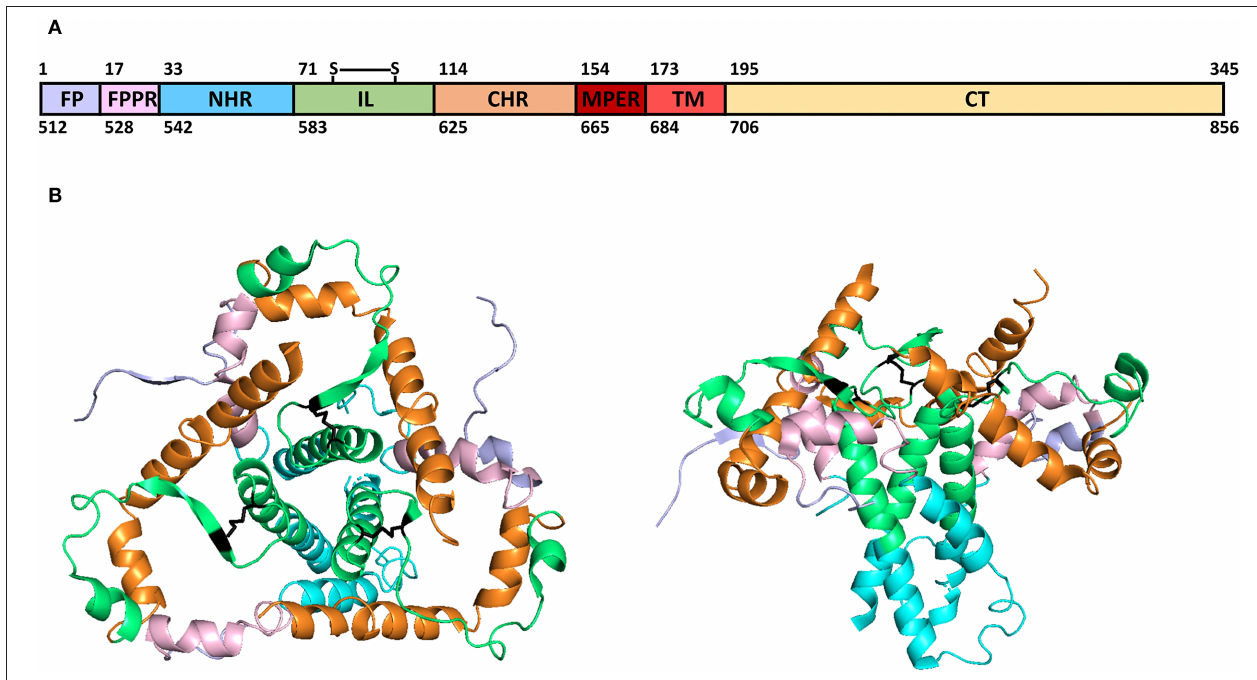
FIGURE 1 | HIV-1 gp41 structural domains (A) and 3D model structure (B) . Color code: light-purple (fusion peptide, FP), light-pink (fusion peptide proximal region, FPPR), blue (N-terminal alpha-helical region, NHR), green (immune-dominant linker, IL), orange (C-terminal heptad repeat region, CHR), dark-red (membrane-proximal external region, MPER), red (transmembrane region, TM), light-yellow (C-terminal domain, CT), and black (disulfide-bridged loop in IL, S-S). (A) Over-domains numbering according to HXB2 isolate aa and below-domains numbering according to HXB2 gp160 nucleotides (Genbank Accession number: K03455). (B) Gp41 3D model structure (PDB ID: 6OLP) (Berman et al., 2000; Rantalainen and Cottrell, 2019; Torrents de la Peña et al.,